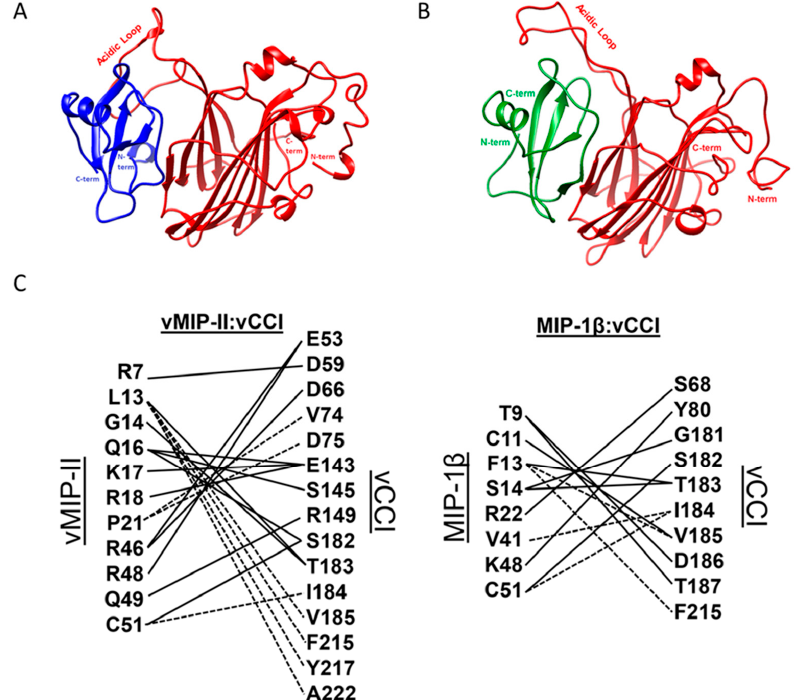
Figure 4. Complexes after 1 µ s molecular dynamics simulation of vCCI:chemokine. For all figures, vCCI is in red ribbon, and the bound chemokine is either blue ribbon (vMIP-II) or green ribbon (MIP-1 β ). ( A ) Structure of vCCI:vMIP-II after 1 µ s trajectory; ( B ) Structure of vCCI:MIP-1 β in complex after 1 µ s trajectory; ( C ) Interactions between residues of vCCI and vMIP-II, as well as vCCI and MIP-1 β . Hydrogen bonds (solid lines) are shown if they appear in at least 50% of the last 300 ns of the molecular dynamics simulation. Dashed lines indicate non-hydrogen-bond interactions between residues. These are defined as residues whose access to solvent is occluded upon complex formation at least 50% of the time, and that are within 2.8 Å of the partner residue on the other protein in at least 50% of the structures sampled every 20 ns for the final 500 ns of the